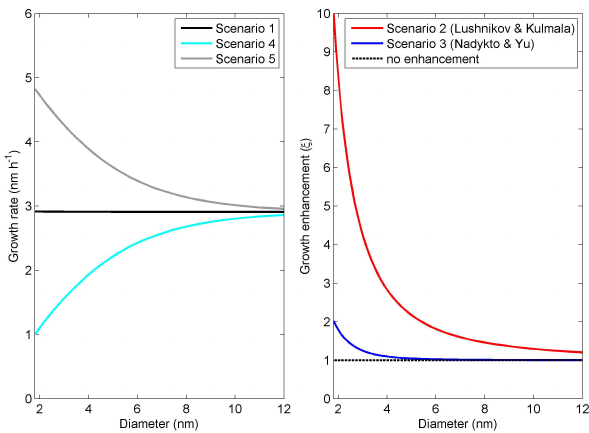
Fig. 1. Left panel: the particle diameter growth rates in the sim- ulations with the same growth rate for neutral and charged par- ticles (scenarios 1, 4 and 5). Only simulations with the value of GR input = 3nmh − 1 are shown here, but the general shape as a function of diameter is similar for other values of GR input . Right panel: the growth enhancement factor of charged particles in the simulations in which the growth rates of neutral and charged parti- cles were different (scenarios 2 and 3). The black dashed line de- notes unity, i.e. no enhancement of the growth